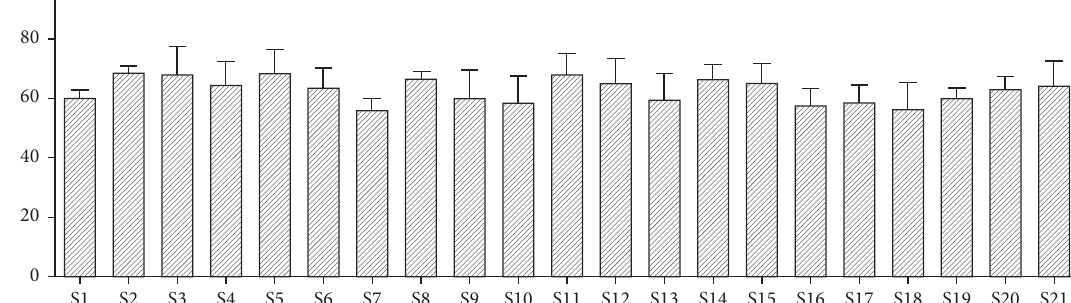
Figure 1: Determination of saponins in Glycyrrhiza uralensis Fisch. from 21 producing areas by UV. The result represents mean ±